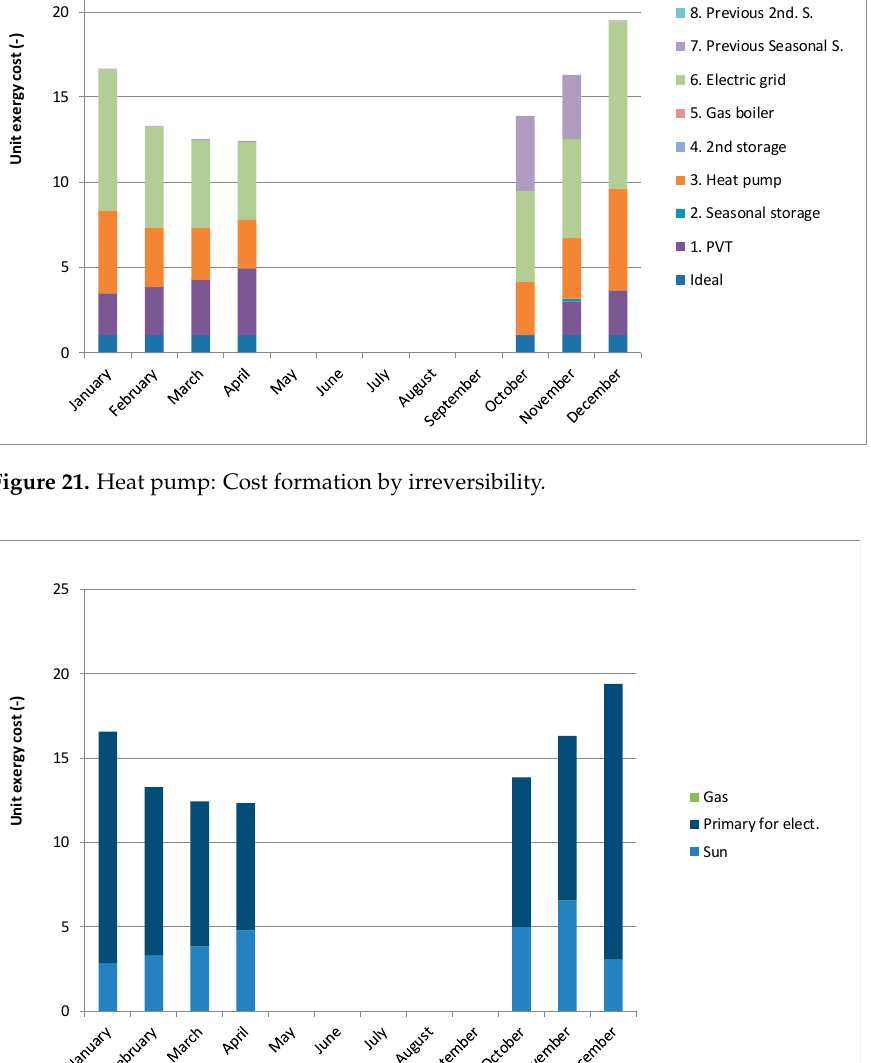
Figure 22. Heat pump: Cost formation by source.